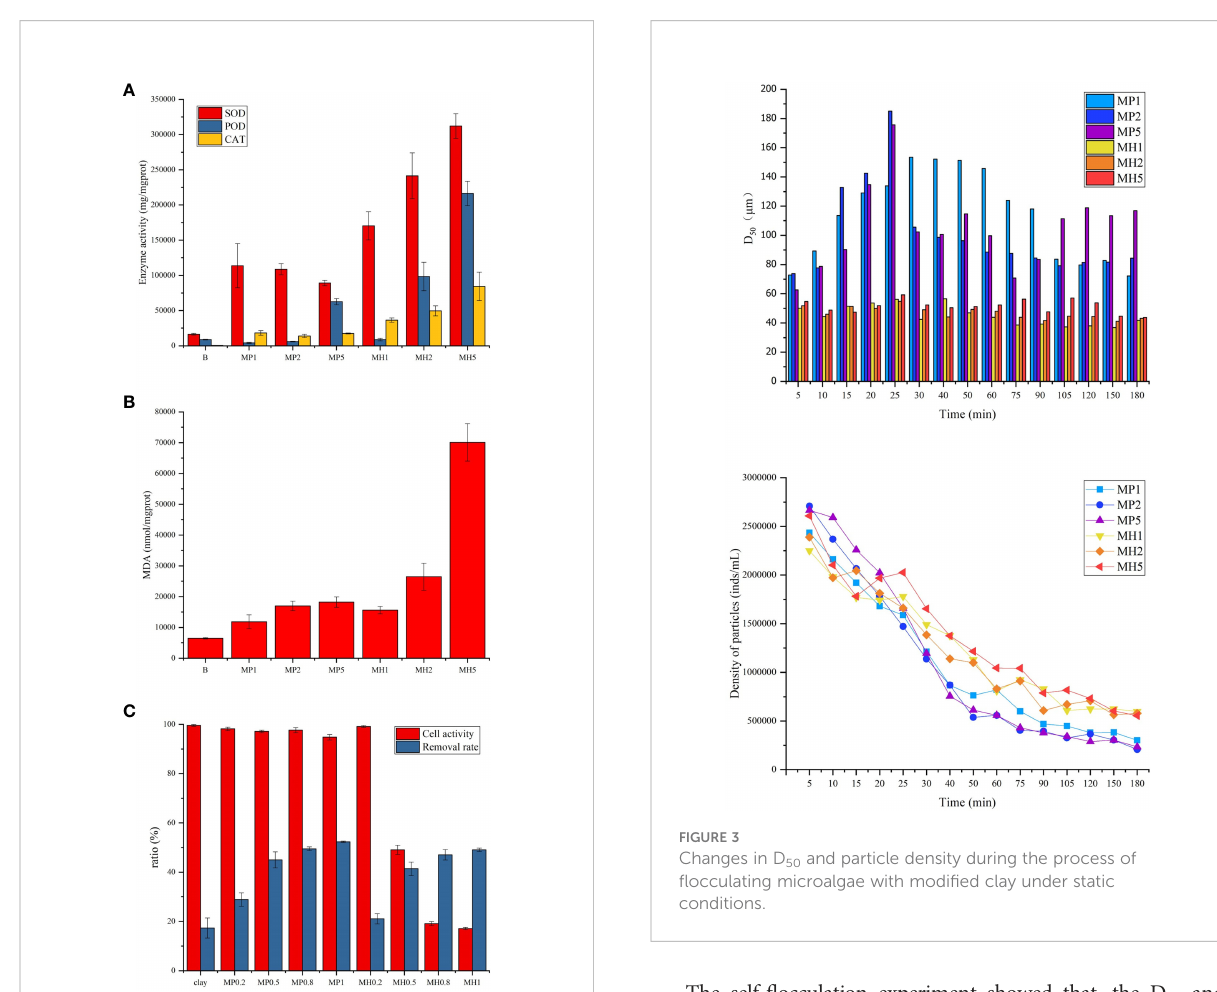
FIGURE 2 Effects of two modi fi ed clays on antioxidant enzyme activity, MDA and cell activity in P. donghaiense (A – C)